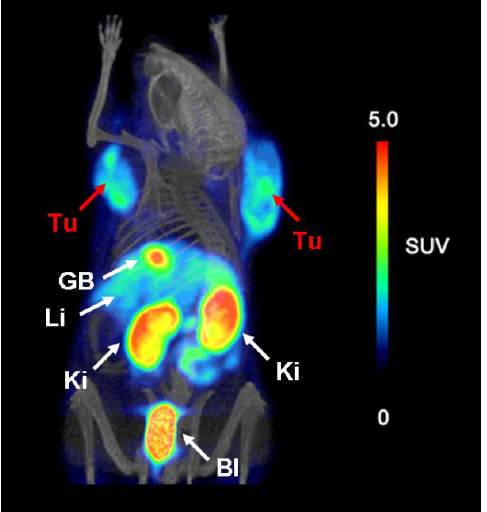
Figure 5. PET/CT image of a mouse 75 min after injection of [ 18 F]fluoro-deoxy-glucose-folate (~14 MBq) [45]. (Tu = KB tumor xenograft, GB = gall bladder, Li = liver, Ki = kidney, Bl = urinary bladder). Reprinted (adapted) with permission from Fischer et al .